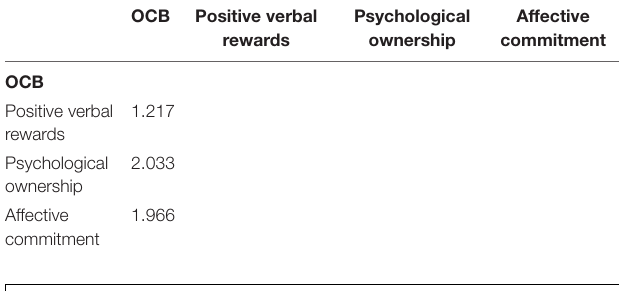
TABLE 2 | Result of the measurement model.